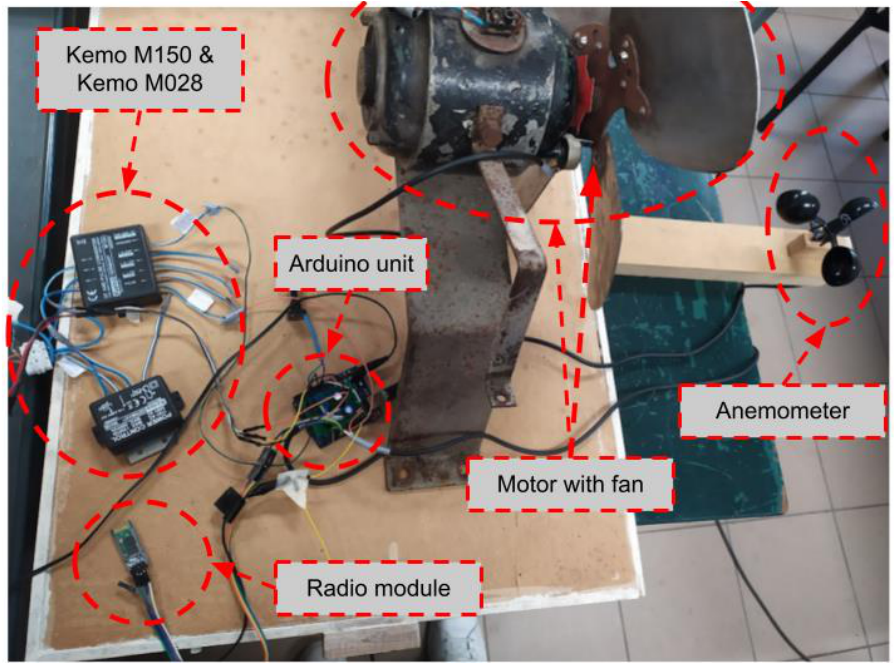
Figure 3. The hardware components used by the ventilation system.